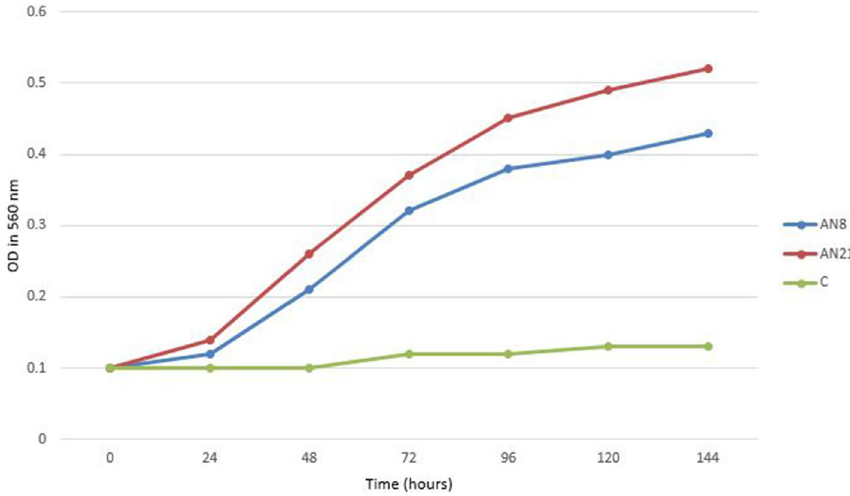
Figure 6. Growth curves of Iranian Nocardia isolates over a 24 h. Incubation period at 30 °C in the presence of sodium sulfate. C control